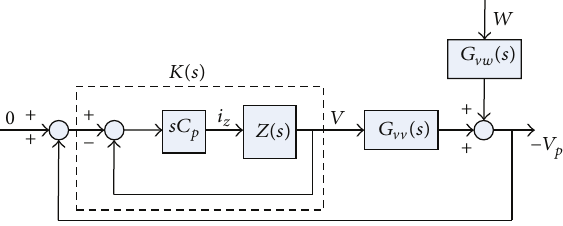
Figure 5: Feedback representation of the controlled